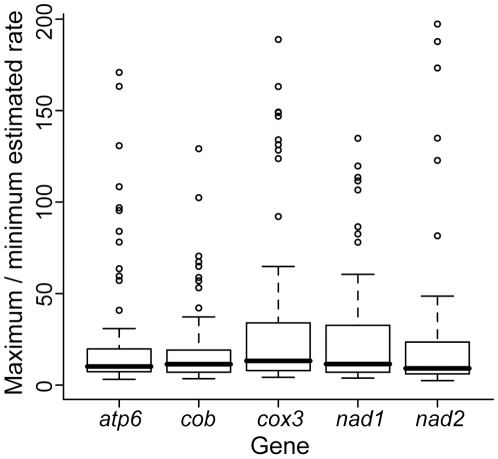
Rate variation observed for datasets simulated on 27-taxon trees and analyzed in an ML framework.Data were simulated with a molecular clock model using the model and model parameters estimated for five mitochondrial genes for plethodontid salamanders [21] (boxes). Up to five outliers were omitted for each gene in order to view the center of the distribution more clearly. Variation was ≤763-fold for atp6, ≤510-fold for cob, ≤777-fold for cox3, ≤257-fold for nad1, and ≤723-fold for nad2.